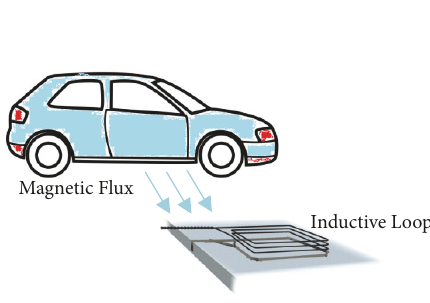
Figure 2: Magnetic loop operation